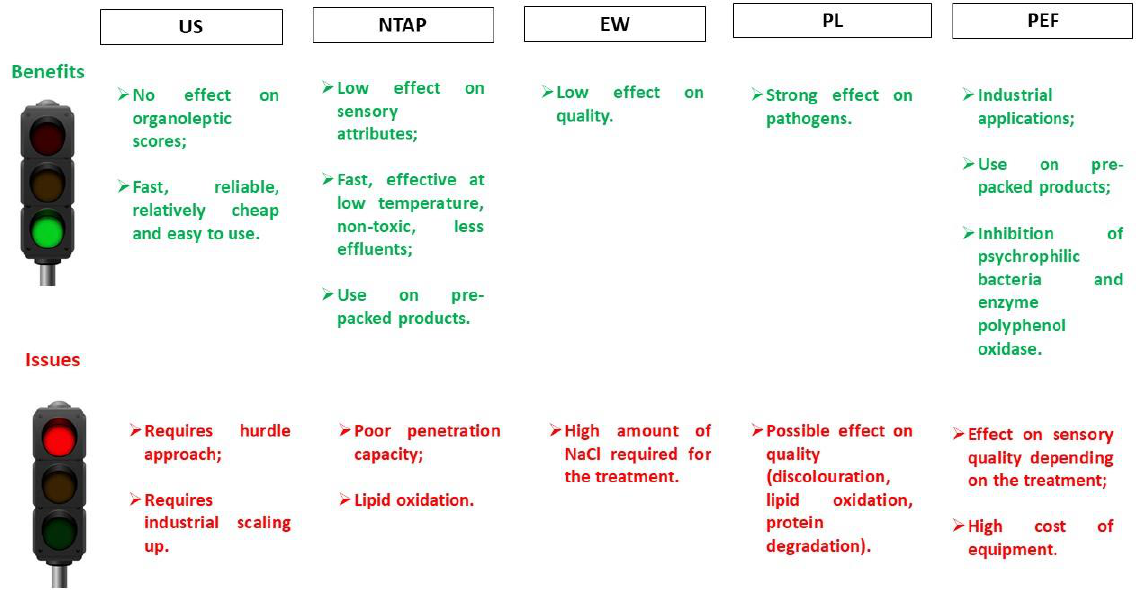
Figure 1. Benefits and issues of non-thermal approaches to prolong the shelf-life of fish. US, ultrasound; NTAP, non-thermal atmospheric plasma; EW, electrolyzed water; PL, pulsed light; PEF, pulsed electric field.